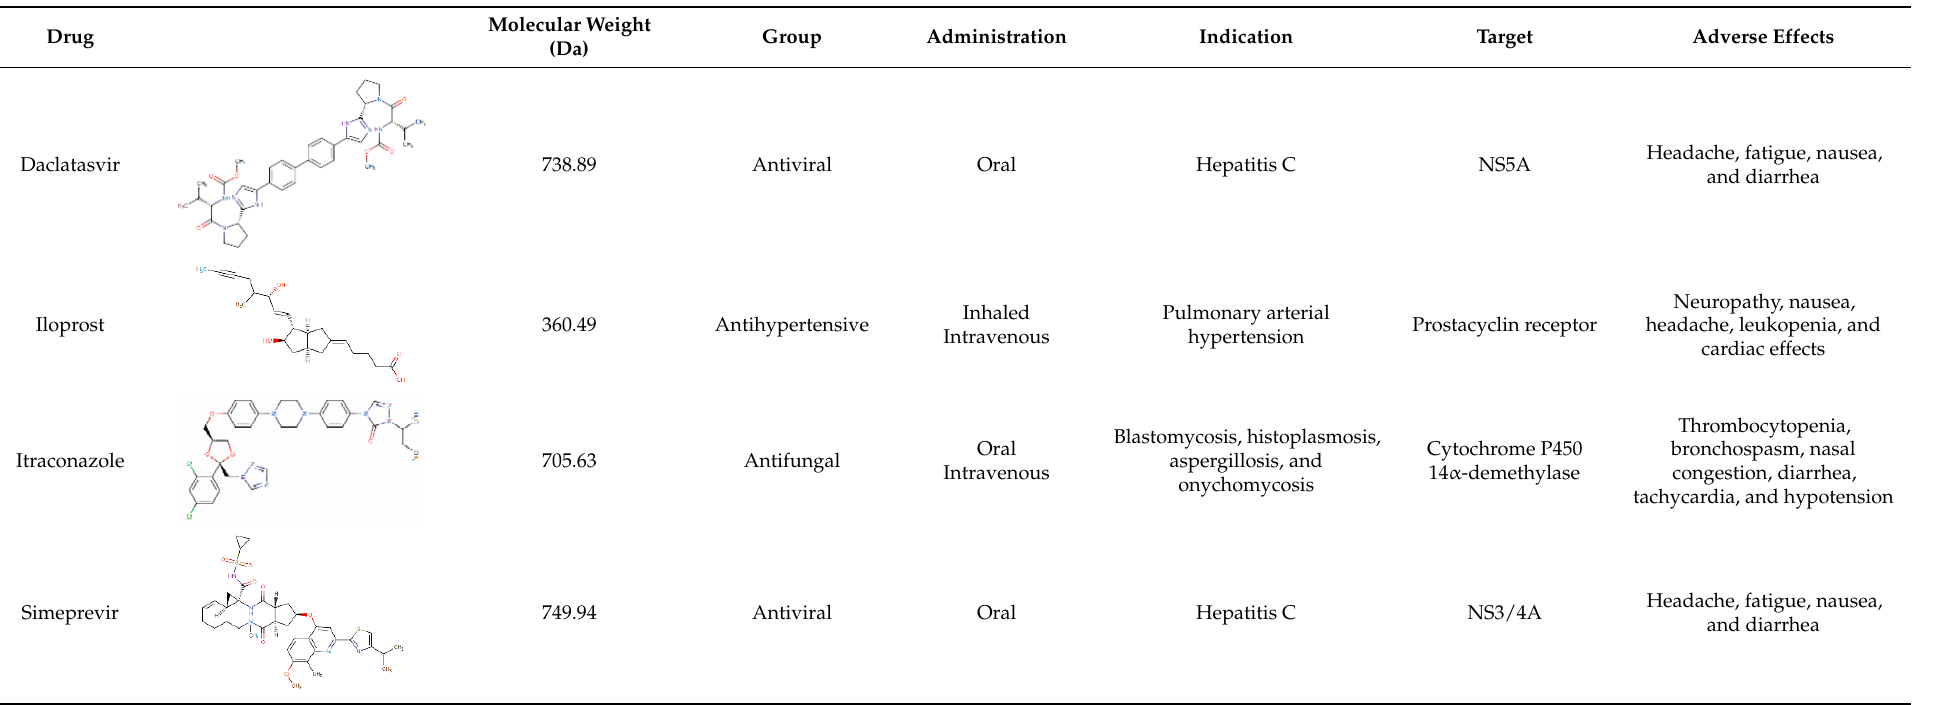
Table 1. Particular aspects of preselected molecules. Available on Pubchem (https://pubchem.ncbi.nlm.nih.gov/) and DrugBank (https://go.drugbank.com/)